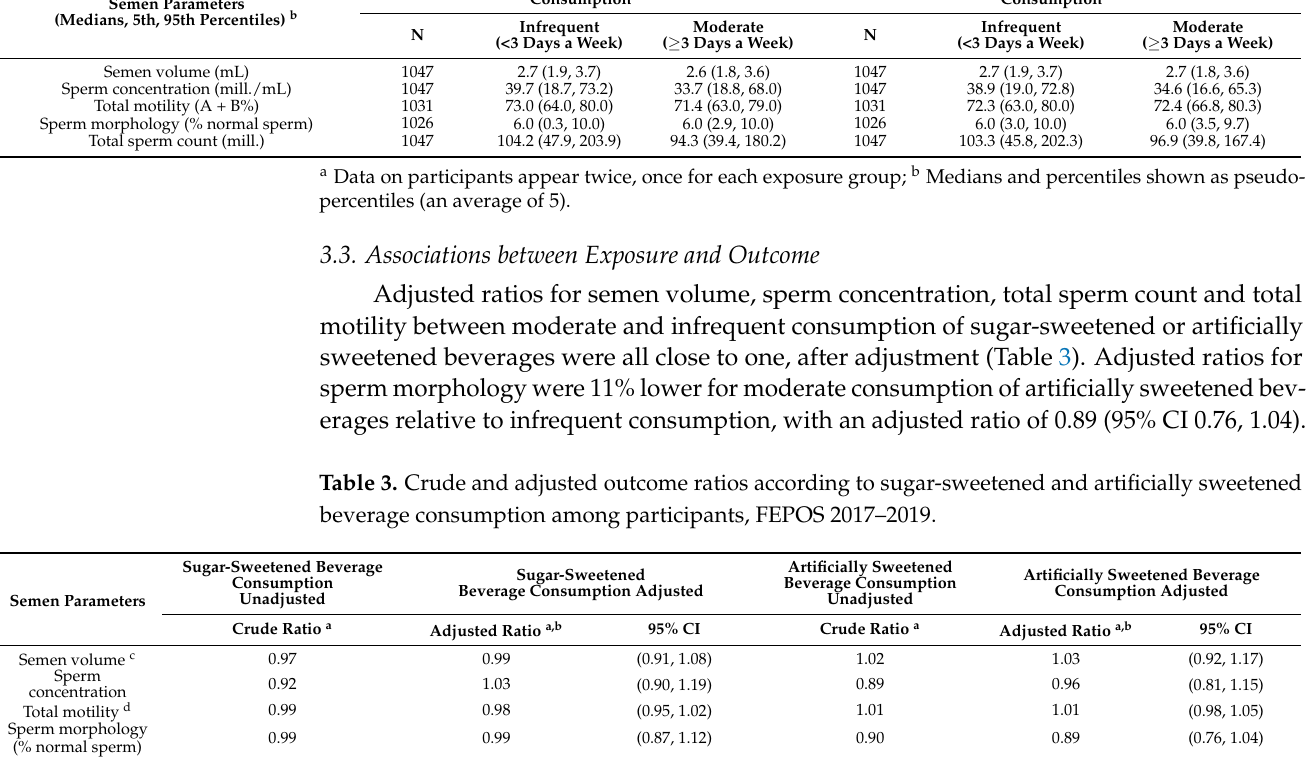
(Table S3) in the analyses of sugar-sweetened beverage consumption and semen quality parameters did not change the